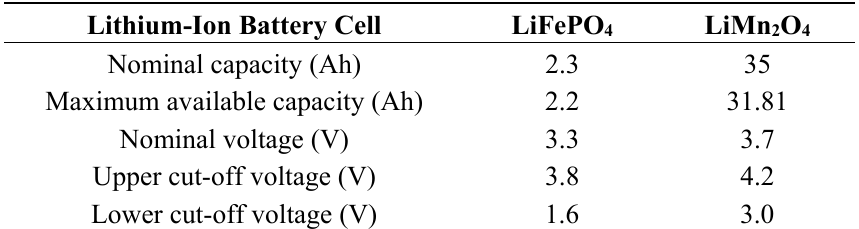
Table 1. Main specifications of the two types of batteries.